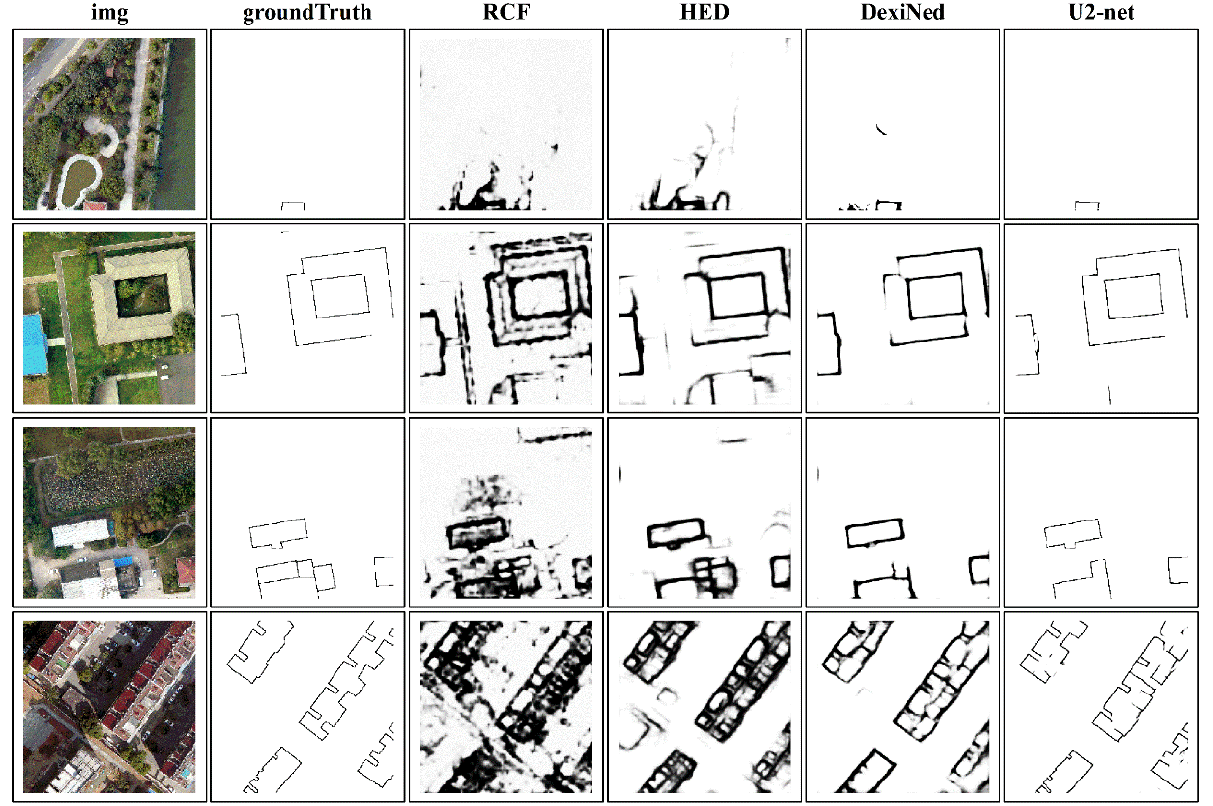
Figure 5. Visual comparison of different edge detection models on Nanjing dataset.